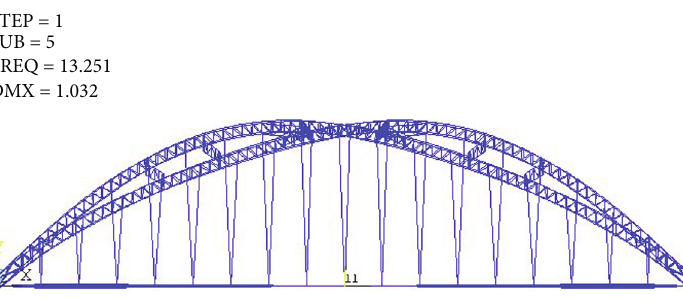
Figure 26: The fi fth order buckling mode of arch bridge under case